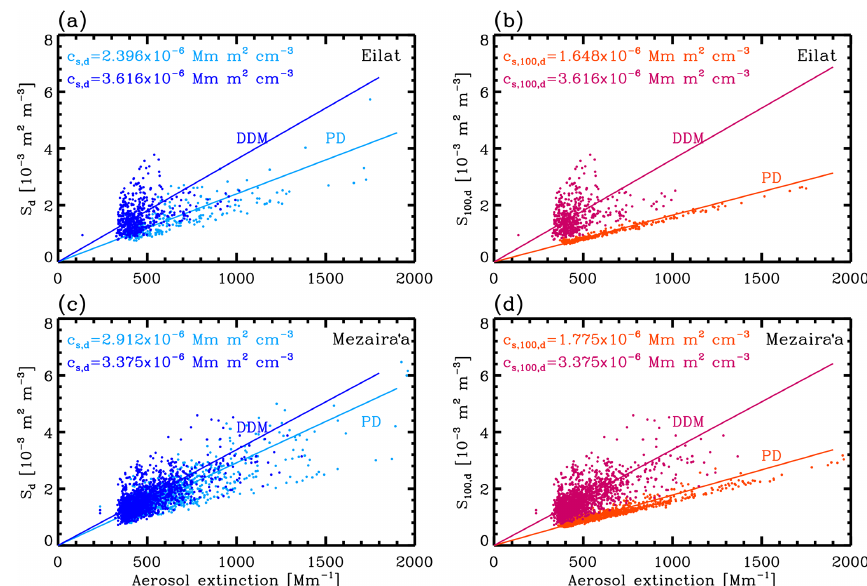
Figure A1. Relationship between aerosol extinction coefficient at 532nm and surface area concentration s d and s 100 , d (only considering particles with a radius > 100nm) for pure dust (PD) and dust-dominated mixture (DDM) at two Middle East sites, i.e., (a, b) for Eilat and (c, d) Mezaira’a. The PD and DDM data points are determined by the AERONET V3 database (level-2.0 AOD products and level-2.0 aerosol inversions) according to the method from Shin et al. (2019). The corresponding dust-related conversion factors c s , d and c s , 100 , d are also given,